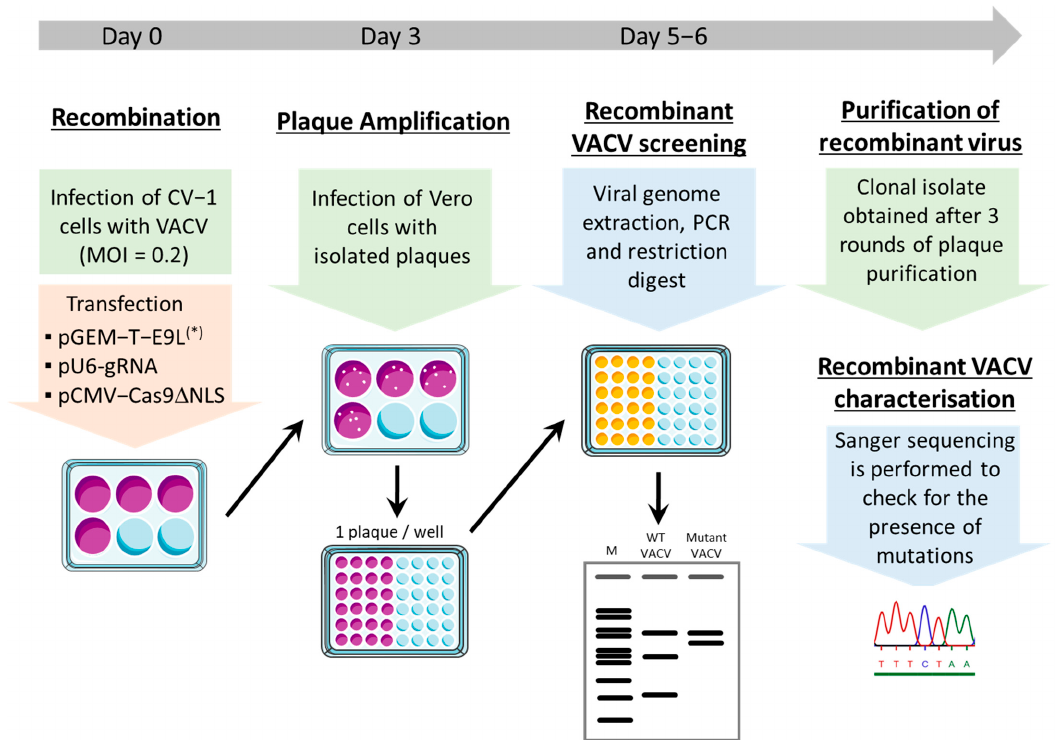
Figure 1. Overview of the rapid generation of point mutations in the VACV genome using Crispr/Cas9, showing the steps leading to mutant VACV selection. Recombination takes place in CV-1 cells, where VACV genome cleavage is induced by Cas9/gRNA. (*) E9L carries a silent mutation in the PAM motif adjacent to the DNA sequence targeted by the gRNA, and eventually other mutations of interest (see text). VACV plaques are amplified, and restriction pattern analysis of E9L is performed. Mutant viruses are then plaque-purified and further characterized by sequencing.